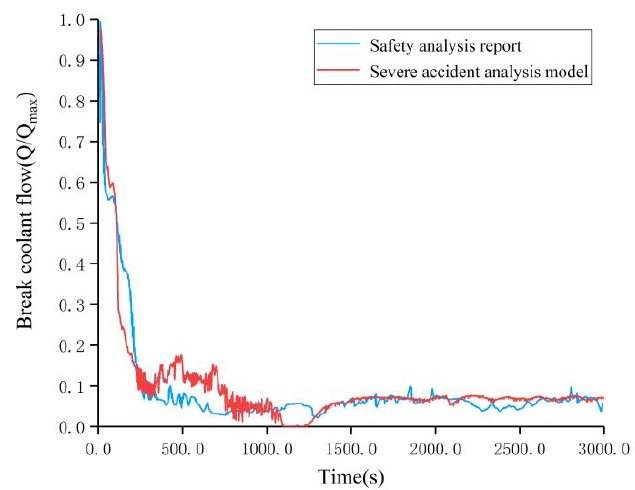
Figure 4. The variation curve of the core water level over time.